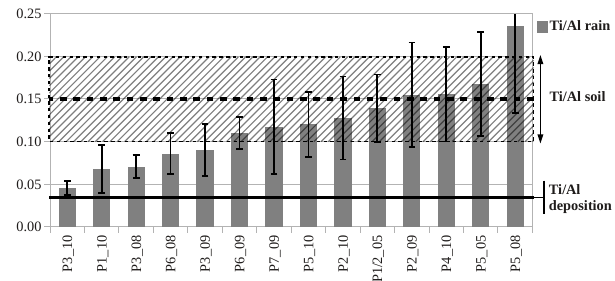
Fig. 4. Ti/Al ratios in rainwater samples (grey histogram), in soil samples (dotted black line + hatched rectangle for uncertainties; Heimburger et al., 2012a) and in deposition samples (black line; Heimburger et al., 2012a). Ti/Al in P3_10, P1_10, P3_08, P6_08 and P3_09 exhibit values not compatible with the range of Ti/Al found in soil collected on the Kerguelen Islands; these five rains were then considered as not significantly influenced by local soil contamination and so representative of long-range transport parti-